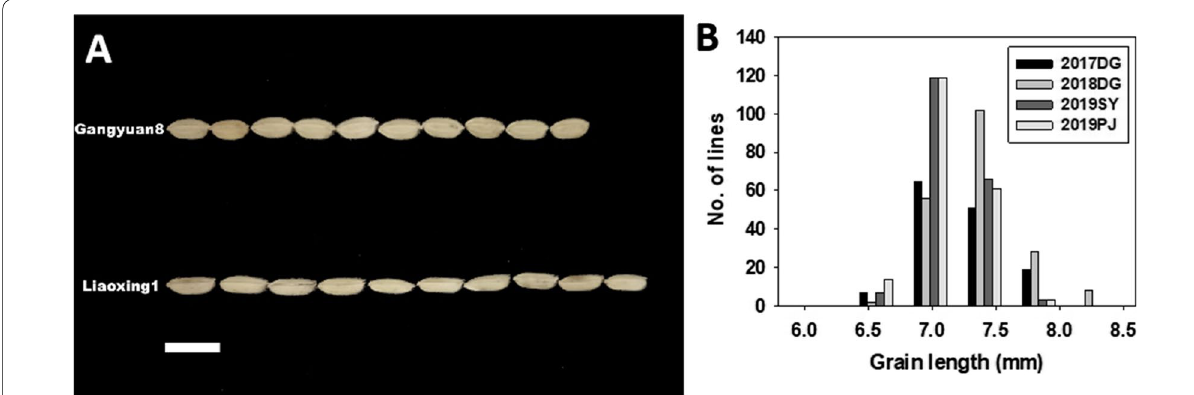
Fig. 1 Difference of grain length between Gangyuan8 and Liaoxing1 ( a ) and the frequency distributions of grain length ( b ) in the RIL population in four environments. DG, Donggang; SY, Shenyang; PJ,